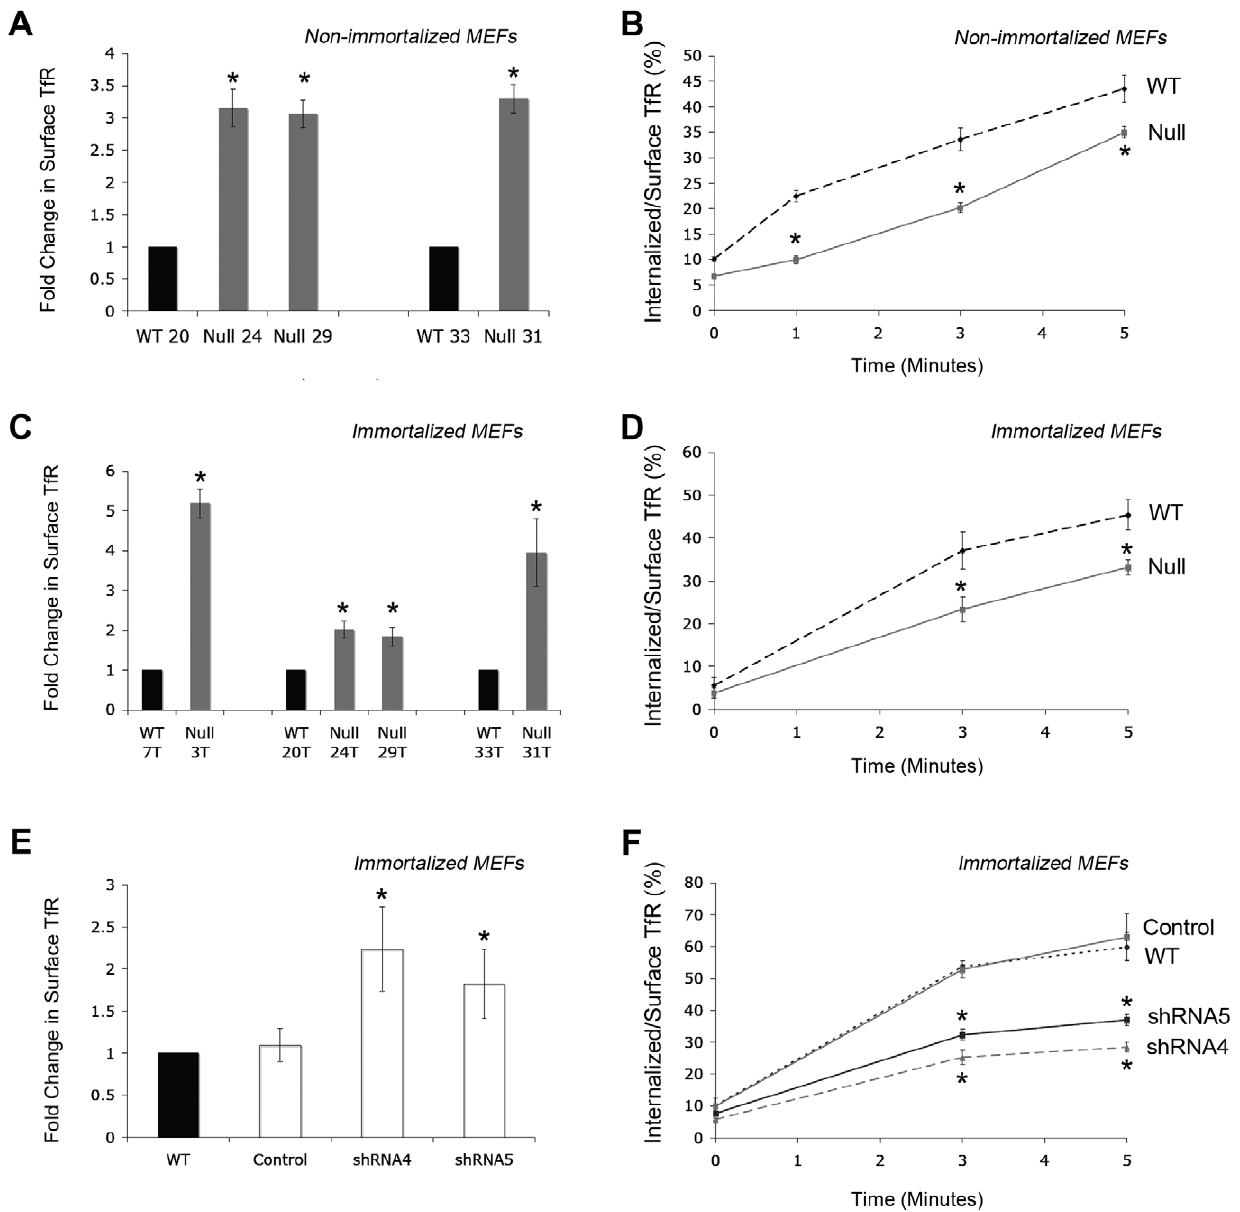
Figure 2. Absence of PICALM results in a decreased rate of internalization and increased cell surface expression of TfR in MEFs. The level of cell surface TfR expression normalized to levels in WT cells ( A,C,E ) and the rate of TfR internalization ( B,D,F ) was measured in non- immortalized MEFs ( A,B ), immortalized MEFs ( C,D ), or PICALM shRNA knockdown WT (line 7T) MEFs ( E,F ). ( A ) Surface TfR expression in non- immortalized WT and Picalm NULL MEFs. N exp =4. *p , 0.02 compared with WT. ( B ) TfR internalization at three different time points in independently derived non-immortalized WT (lines 20, 33) and Picalm NULL (lines 24, 29, 31). N exp =2. *p , 0.04 compared with WT. ( C ) Surface TfR expression in immortalized WT and Picalm NULL MEFs. N exp =4. *p , 0.04 compared with WT. ( D ) TfR internalization in independently derived immortalized WT (lines 20T, 33T) and Picalm NULL (lines 24T, 29T, 31T). N exp =7. *p , 0.01 compared with WT. ( E ) Surface TfR expression in shRNA transduced WT MEFs. N exp =4. *p , 0.02 compared with WT. ( F ) TfR internalization in immortalized WT (line 7T) transduced with two separate PICALM shRNA retroviruses (shRNA4, shRNA5) or a control shRNA retrovirus. N exp =3. *p , 0.01 compared with WT. In all cases, error bars denote standard error. Two-tailed Student’s t-test was used to compare means for TfR internalization